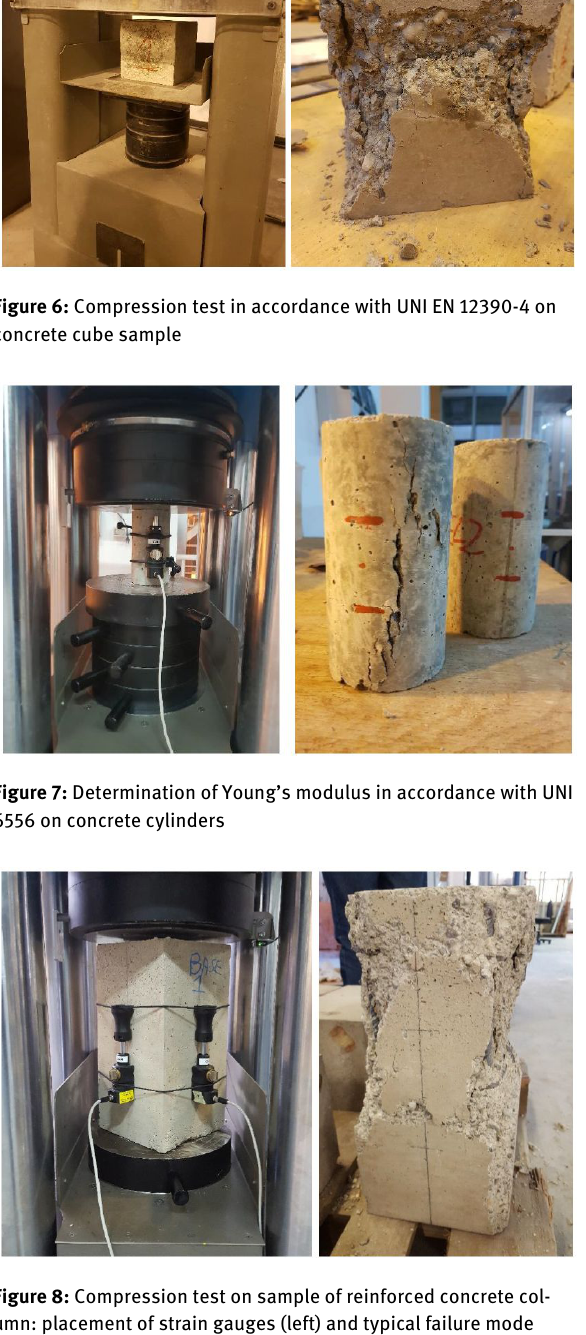
concrete core concept introduced by Mander et al. [20].